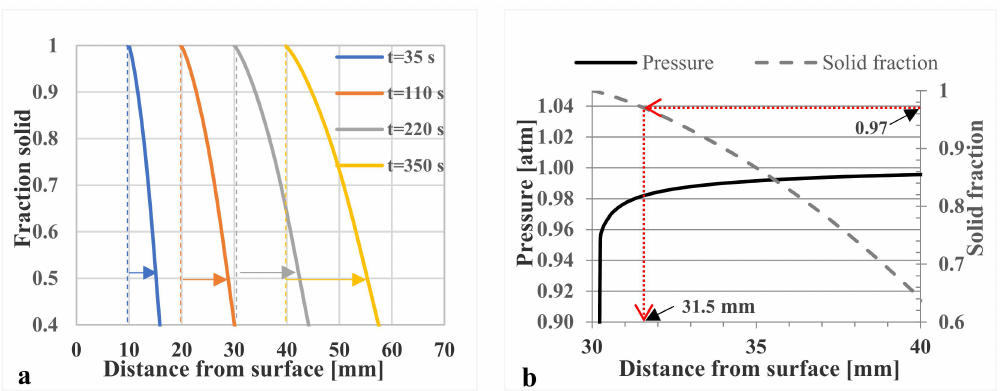
Figure 21. ( a )The fraction solid is plotted against the distance from the billet surface at the times 35 s, 110 s, 220 s, and 350 s. ( b ) Pressure and solid fraction against distance in the mushy